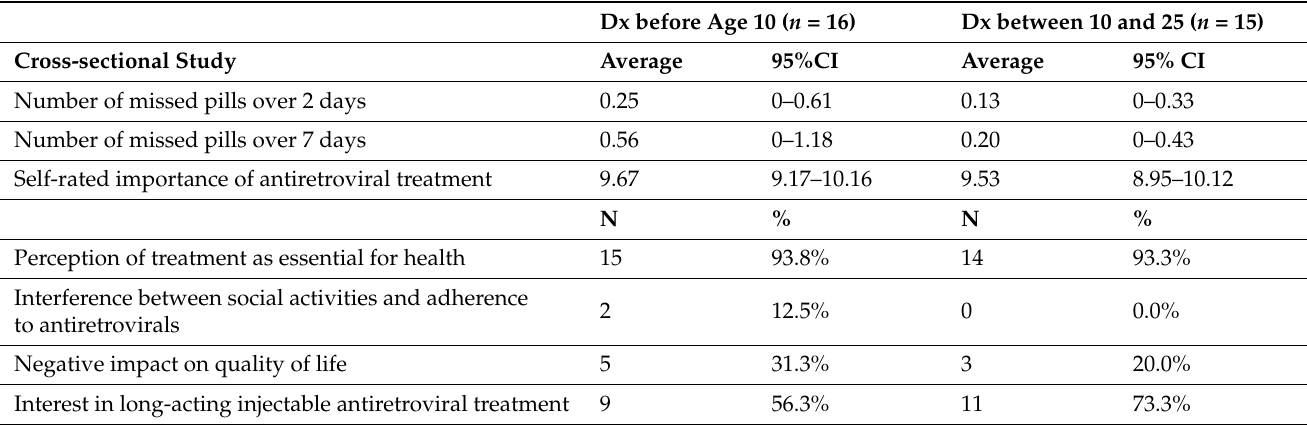
Table 3. Comparative data for the cross-sectional